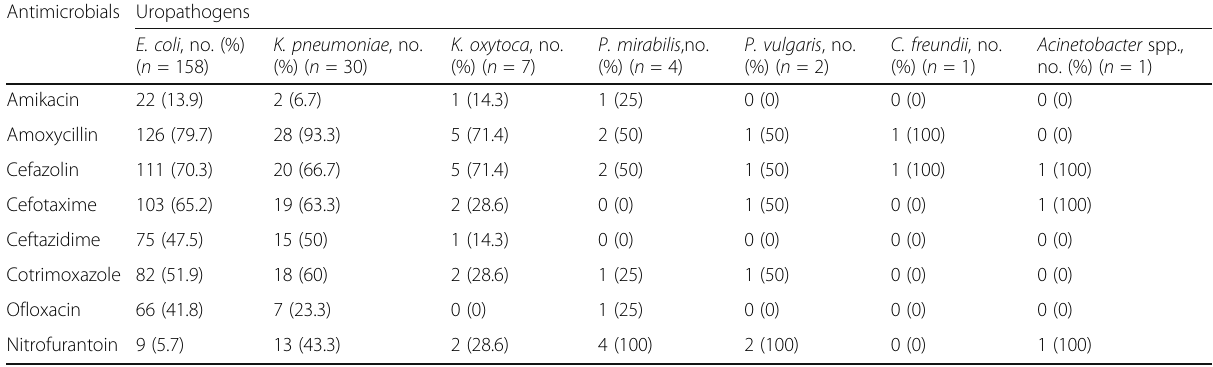
Table 2 Antimicrobial resistance patterns of uropathogens in children in Siddhi Memorial Hospital, Bhaktapur, Nepal Antimicrobials Uropathogens E. coli , no. (%) ( n =